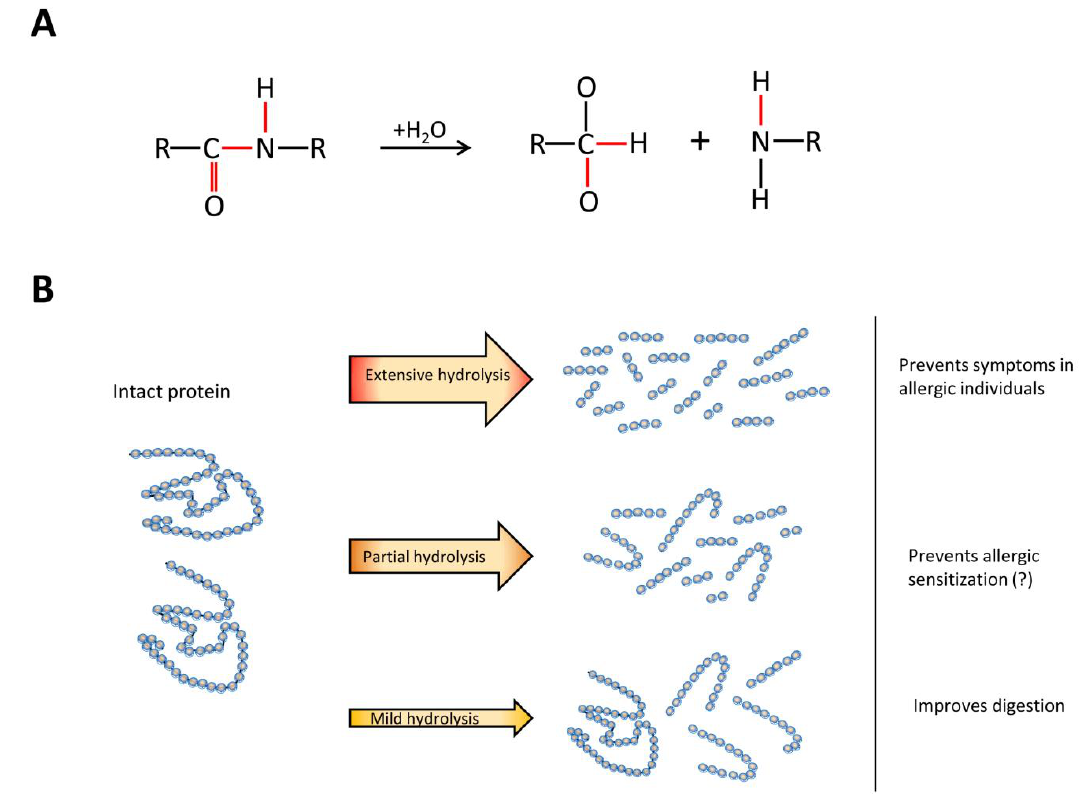
Figure 1. The process of protein hydrolysis and its products. ( A ) chemical reaction of protein hydrolysis; ( B ) different hydrolysates serve different purposes.